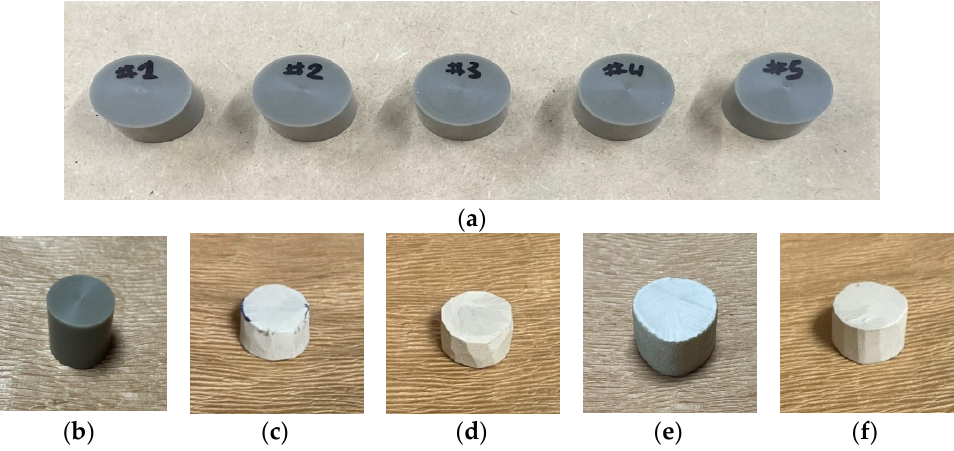
Figure 5. Specimens for high-frequency measurements: ( a ) Non-foamed; ( b ) Original; ( c ) Microcellu- lar foamed at 150 ◦ C and 30 s; ( d ) Microcellular foamed at 150 ◦ C and 90 s; ( e ) Microcellular foamed at 170 ◦ C and 30 s; ( f ) Microcellular foamed at 170 ◦ C and 90